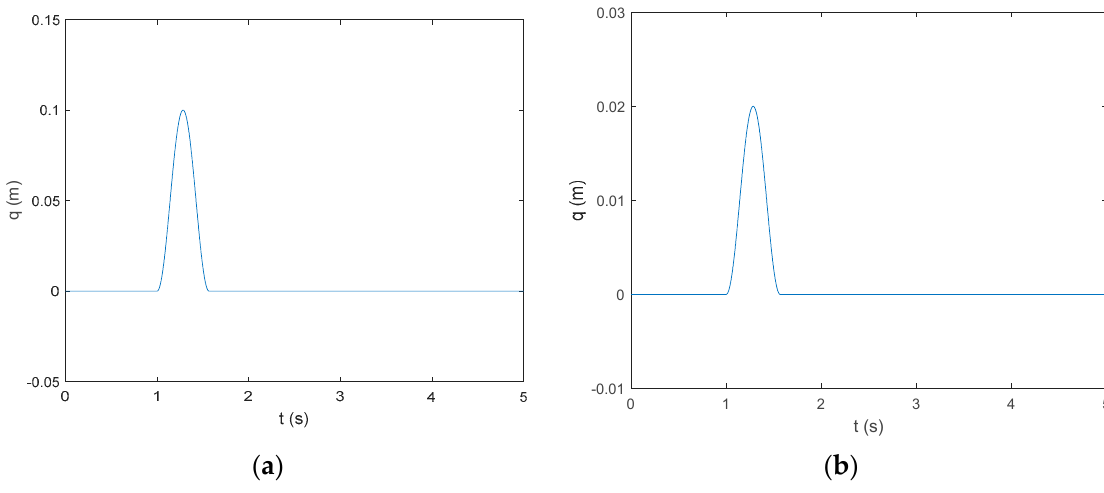
Figure 5. Bump excitation: ( a ) a = 0.1 m; ( b ) a = 0.02 m .